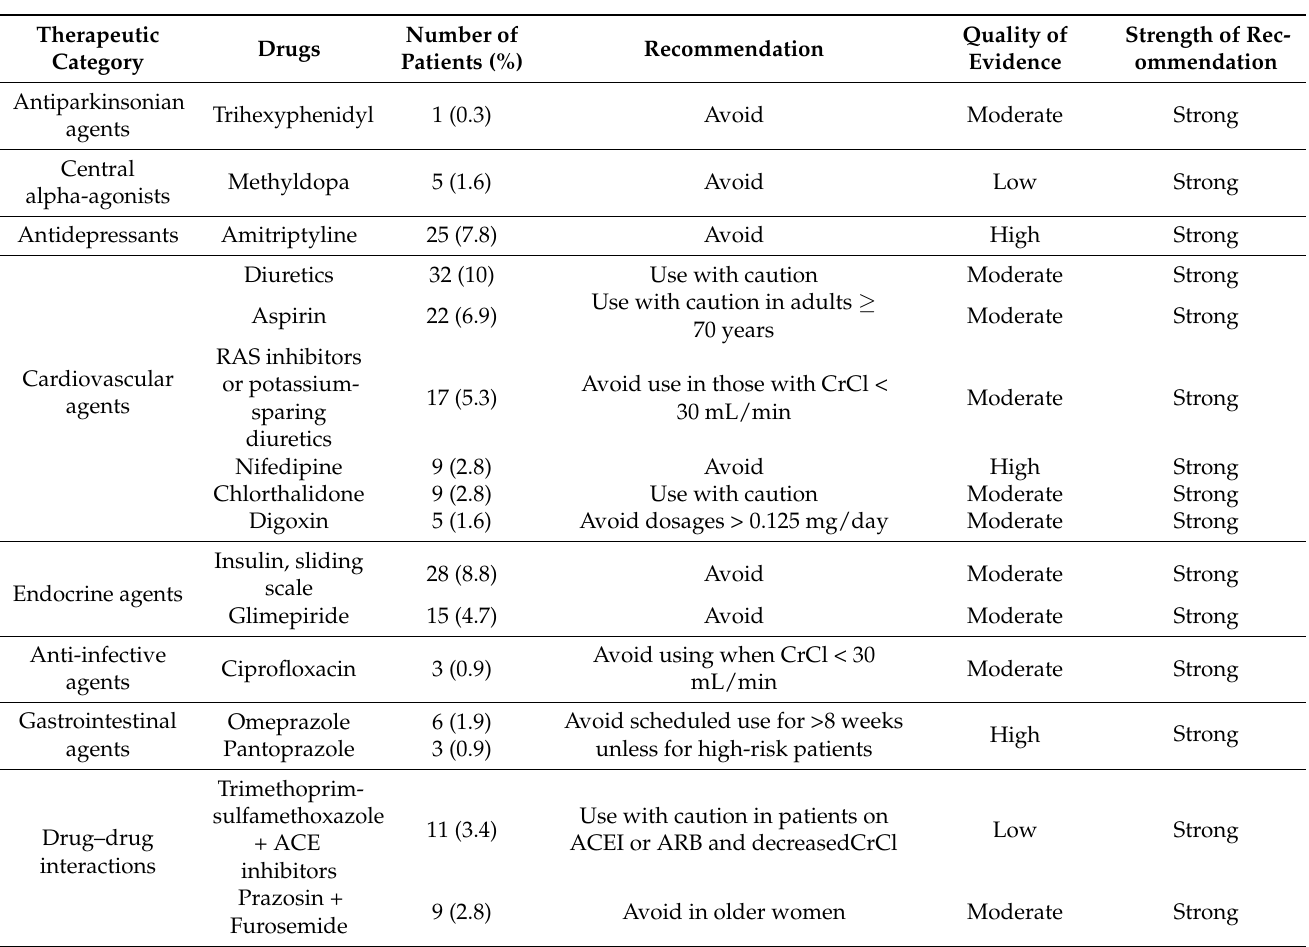
Table 2. Potentially inappropriate medication use among older outpatients according to 2019 AGS Beers criteria (total PIMs =